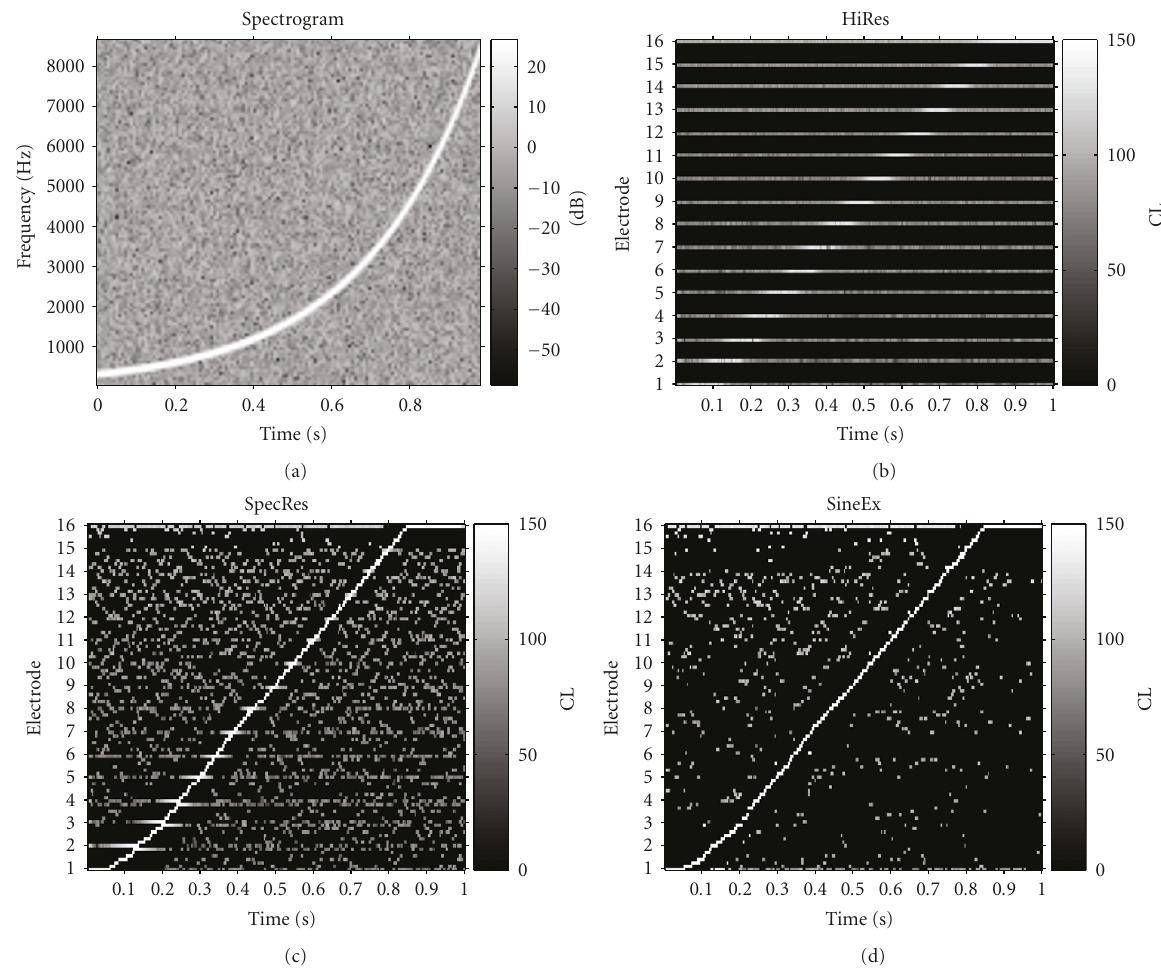
Figure 7: Stimulation patterns obtained with (b) HiRes, (c) SpecRes, and (d) SineEx in noise (SNR = 10 dB) when the input signal is a sweep tone of 1 millisecond of constant amplitude (70dB) and frequency varying from 300 Hz until 8700 kHz added with white Gaussian noise (SNR = 10 dB) shown in (a). The horizontal axis represents time in seconds, and the vertical axis represents the electrode location. The level applied in current level (CL) is coded by the colors given in the color bars. The location of excitation is obtained as presented in Section